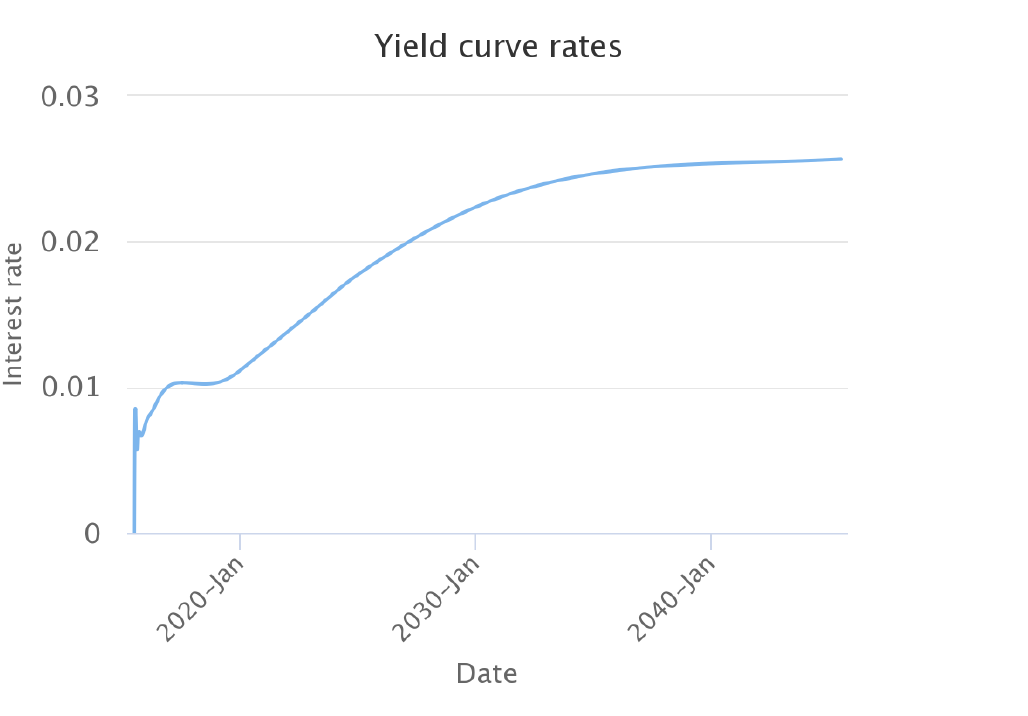
Figure 8. Yield curve of the Italian government